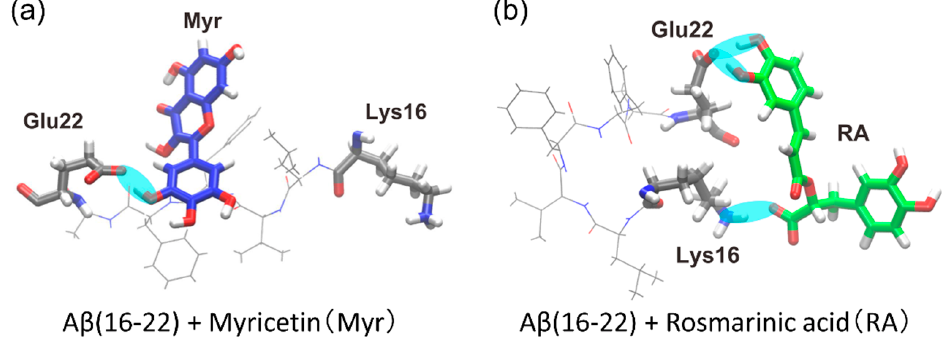
Figure 7. Typical snapshots obtained from the replica-permutation MD simulations of the ( a ) Myr system and ( b ) RA system. The hydrogen bonds between the polyphenols and the A β (16–22) peptide are indicated by the cyan ovals. Reprinted with permission from Ref. [31]. Copyright 2020 Elsevier.